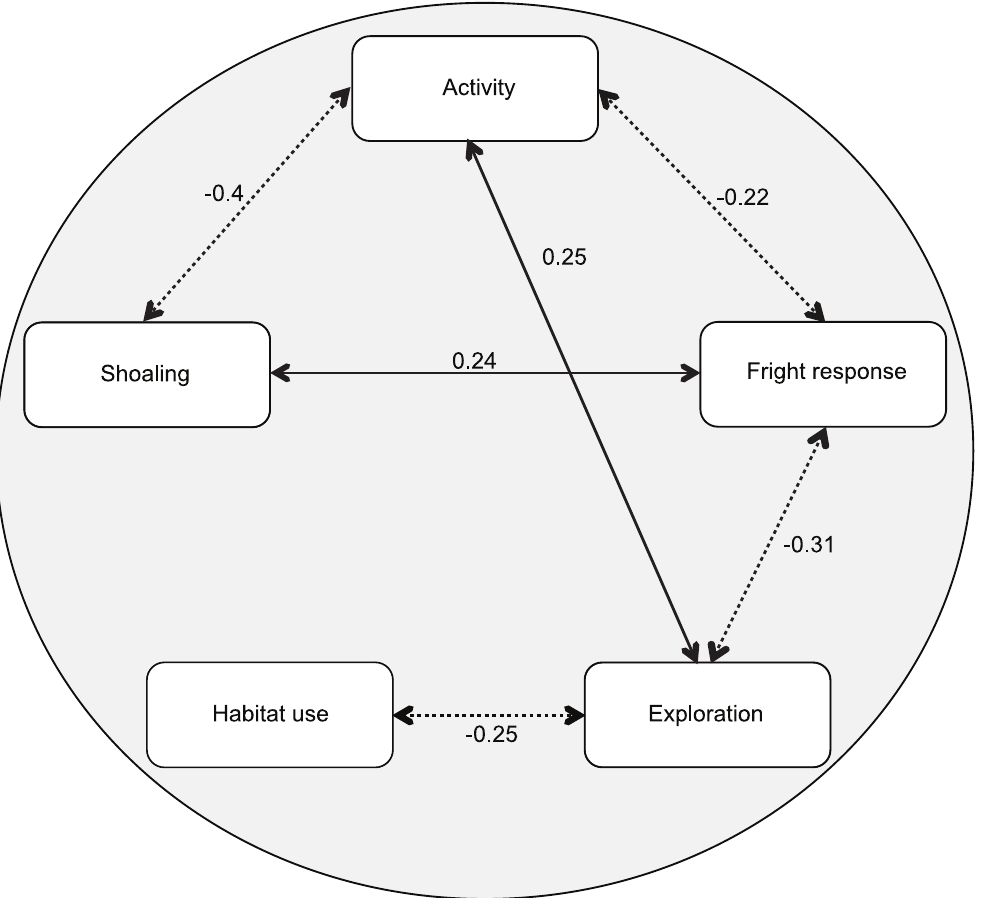
Figure 3. A behavioural syndrome in rock pool prawns. Arrows interlinking behaviours indicate significant relationships, with solid lines representing positive correlations and dotted lines for negative correlations. The correlation coefficient is also shown.